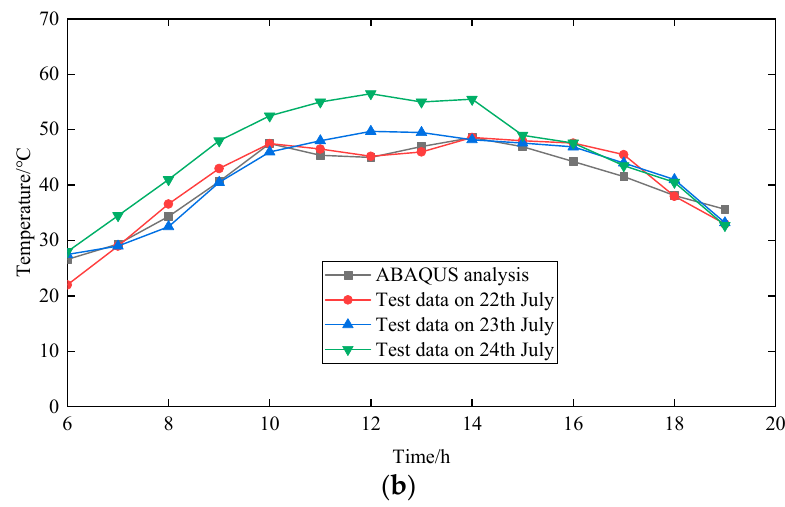
Figure 11. Measured temperature curve [28] and calculated temperature curve of H-shaped steel sample. ( a ) Temperature curve of point-1. ( b ) Temperature curve of point-2.